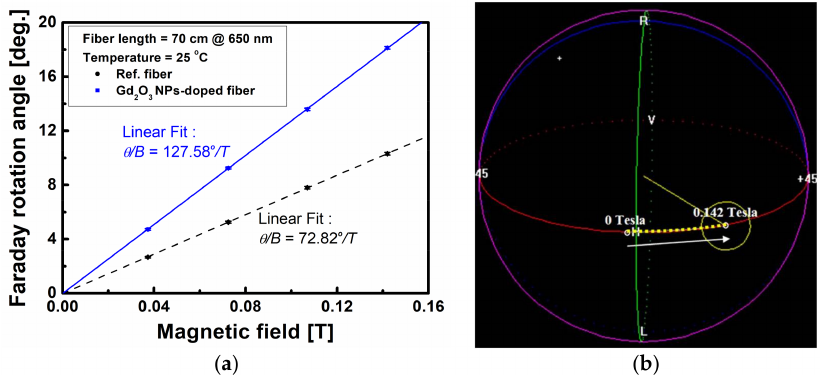
Figure 5. ( a ) Variation of the FRA with the increase of magnetic field at room temperature and